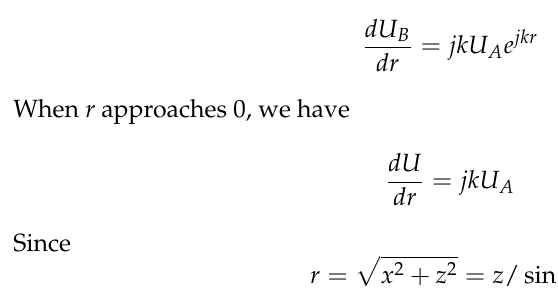
Figure 1. Schematic diagram of the reflected wave at point A on the surface.